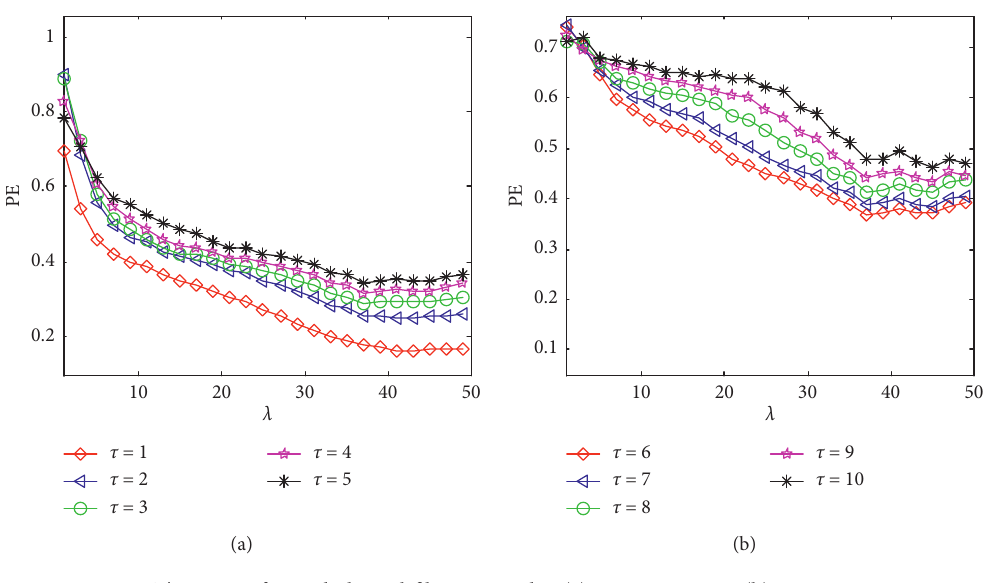
Figure 5: The MPE of morphological filtering results: (a) τ � 1 , 2 , . .. , 5; (b) τ � 6 , 7 , ... ,